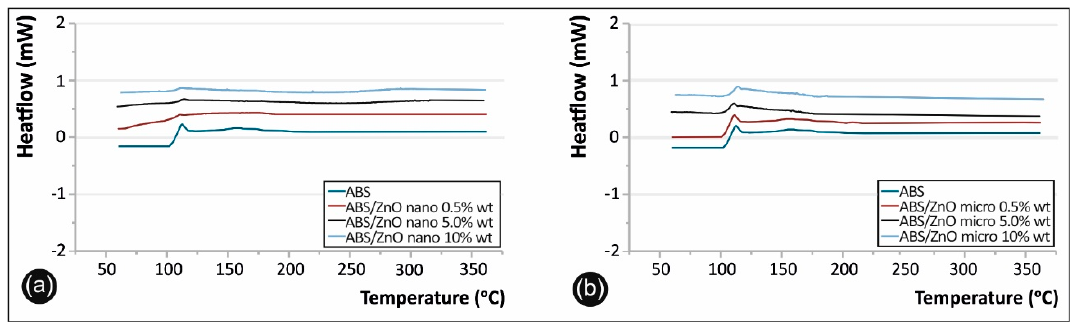
Figure 6. ( a ) Differential scanning calorimetry (DSC) curves for ABS, ABS/ZnO nanocomposites and ( b ) ABS/ZnO micro-composites.